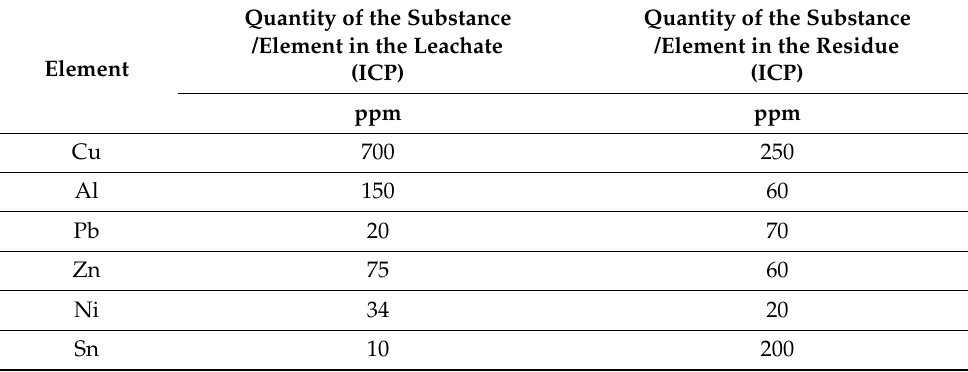
Quantity of the Substance /Element in the Residue (ICP)